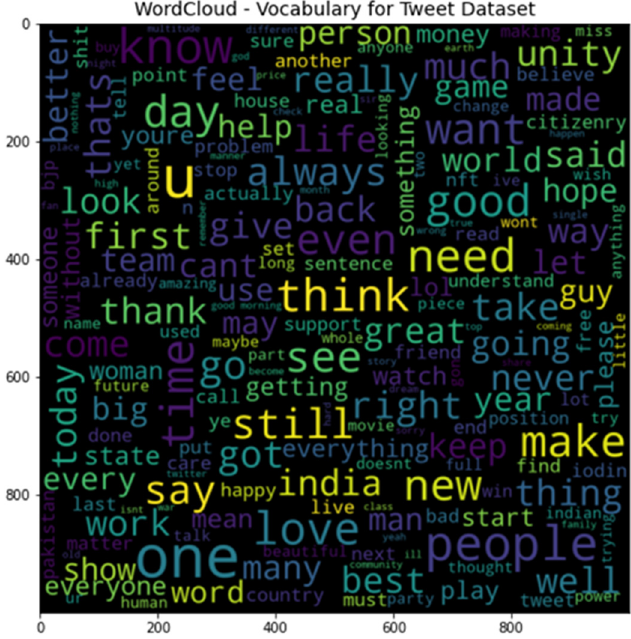
Figure 3. Highlighted words based on their frequency and relevancy in the tweets. Table 3. Most frequent 10 words that appear in the dataset. S. No.